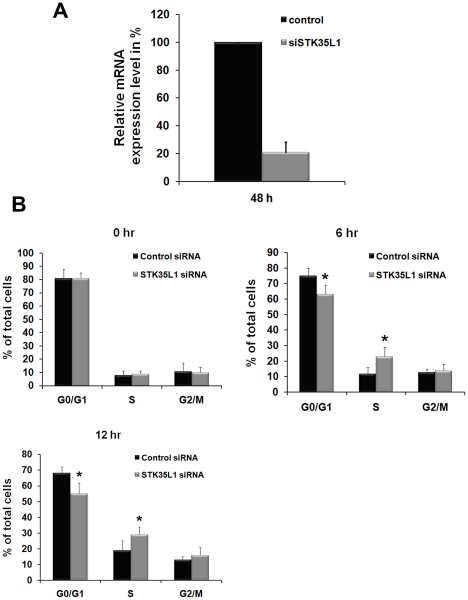
G1 to S-phase progression is accelerated in STK35L1-silenced endothelial cells.A) STK35L1 expression level of STK35L1 silenced cells and control cells. B) Cell cycle distribution of control siRNA- and STK35L1 siRNA treated endothelial cells. Cells arrested in Go/G1 phase were stimulated by serum for various times. Values are mean ± S.E. of three independent experiments. Asterisk “*” indicates level of significance p≤0. 05.